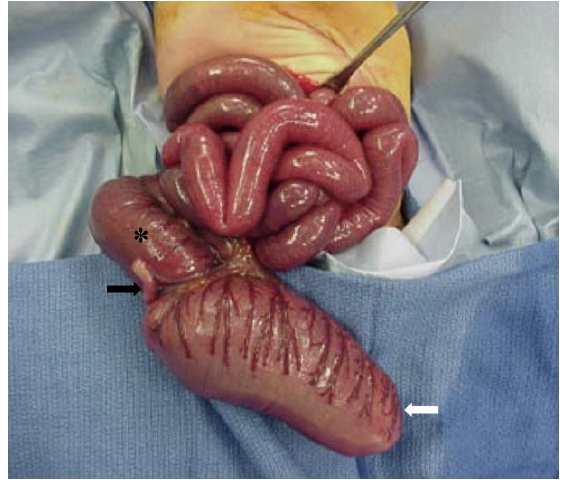
Figure 1: Atresia of the ascending colon in a two-day-old newborn. Atretic blind segment (white arrow), appendix (black arrow), and terminal ileum (asterisk). The distal atretic end was at the sigmoid colon. The proximal end was exteriorized as a colostomy, and the distal end as a mucous fistula. Distal colonic biopsies ruled out associated distal Hirschsprung’s